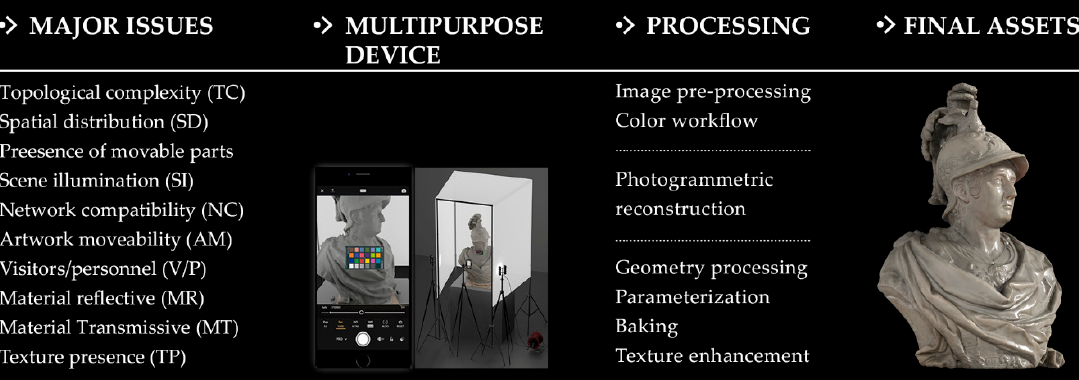
Figure 2. Main steps of the proposed workflow and final 3D models.